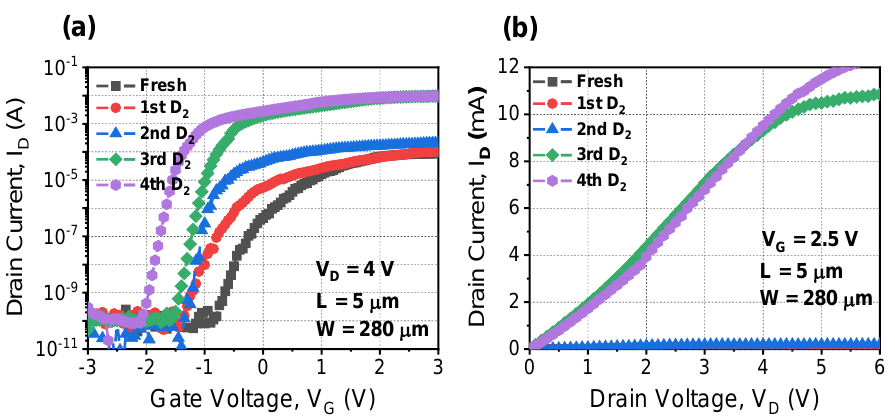
Figure 3. Measured ( a ) I D -V G and ( b ) I D -V D characteristics of the fabricated device after iterative deuterium annealing.